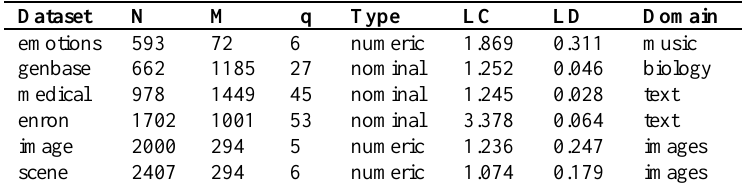
Table 1. Discerption of the datasets used in the